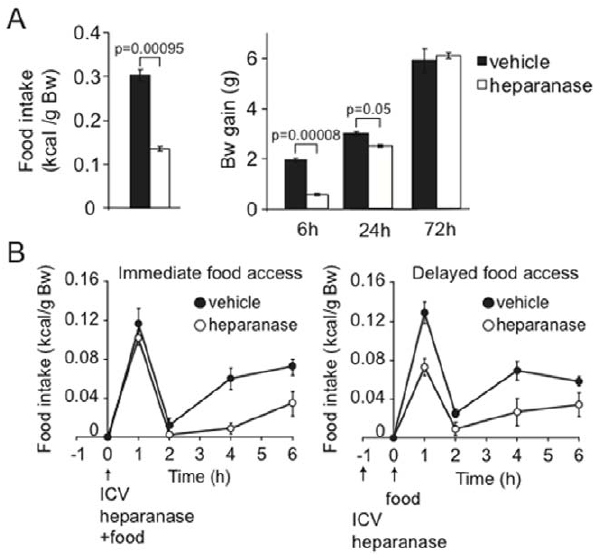
Figure 3. Intracerebroventricular injection of heparanase reduced food intake and body weight gain after fasting. (A) Effect on food intake. C57BL/6J mice (6–8 weeks old) with cannulae inserted for the ICV experiment were fasted for 16 hr, and were then subjected to ICV injection of recombinant heparanase as described in Methods. The mice were allowed access to normal chow immediately after injection, and food intake was measured over the subsequent 6 hr period. The heparanase-treated mice (n=6) showed a . 50% reduction in cumulative food intake, related to body weight, compared to controls (injection of vehicle; n=6). The same mice were weighed at different time points following ICV injections. Reduction in body weight gain of heparanase injected mice, compared to controls, was most apparent after 6 hr, still discernible after 24 hr, but not detectable after 72 hr. (B) Time course of effects due to ICV heparanase injection. Four